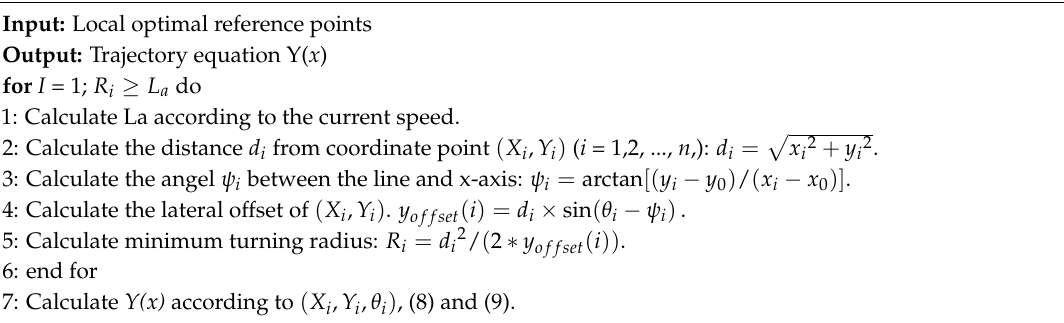
Algorithm 1. Optimal trajectory generation.